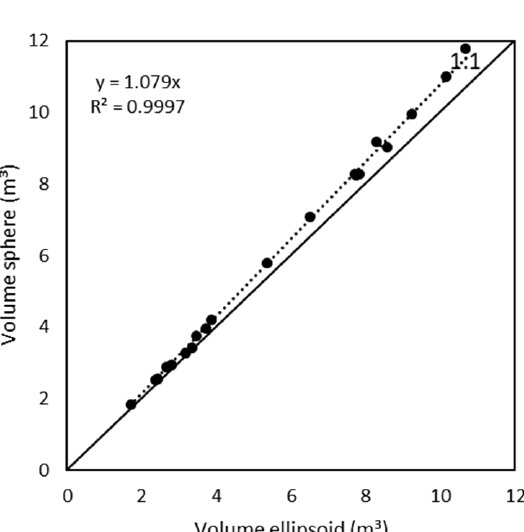
Figure 12. Scatter plot and linear fitting between volume estimations using ground-truth data, assuming the tree crown as a sphere or an ellipsoid. The dashed line is the fitted linear function passing through the origin and the solid line is the 1:1 line. The linear regression between the estimated crown volume using the raster analysis approach and the ground-truth data was calculated, assuming the crown as a sphere (Figure 13a) or an ellipsoid (Figure 13b). Both approaches showed a clear relationship with ground-truth data (R 2 > 0.8; p < 0.05), although they also slightly underestimated them. However, when assuming the pistachio tree crown as a sphere, the RMSE value is slightly higher (RMSE = 2.82 m 3 ) than when assuming an ellipsoid (RMSE = 2.73 m 3